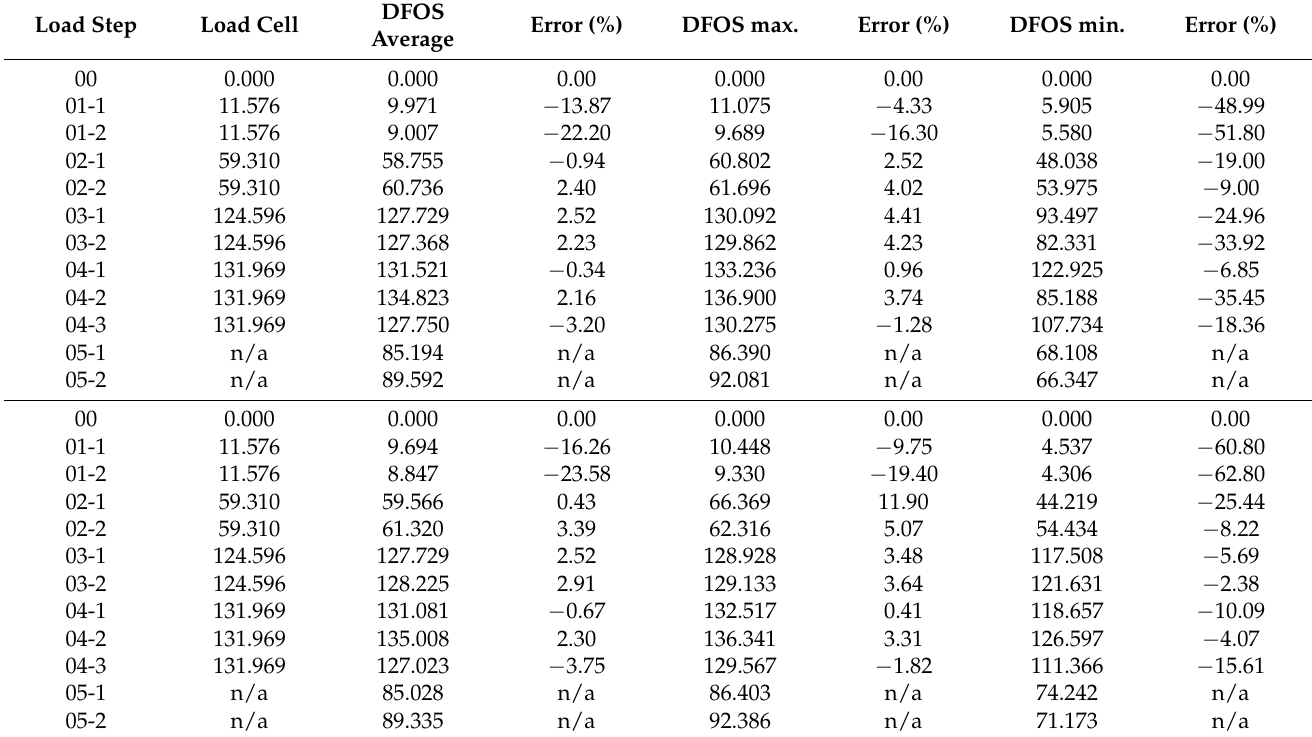
Table 8. Prestressing force monitored by load cell and DFOSs for PC3-1 (unit: kN).